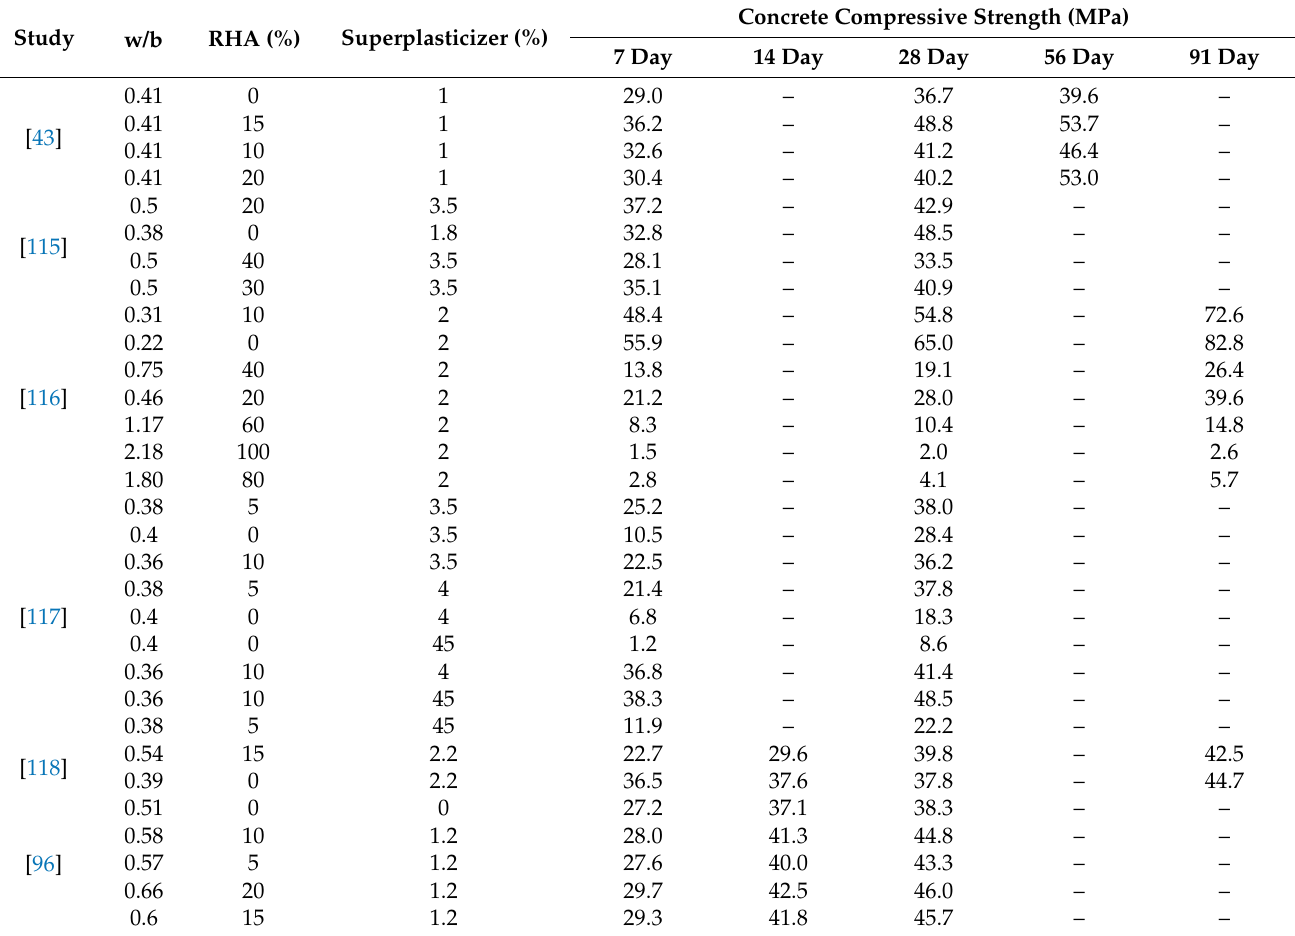
Table 6. Concrete compressive strength of various volume of RHA by various scholars